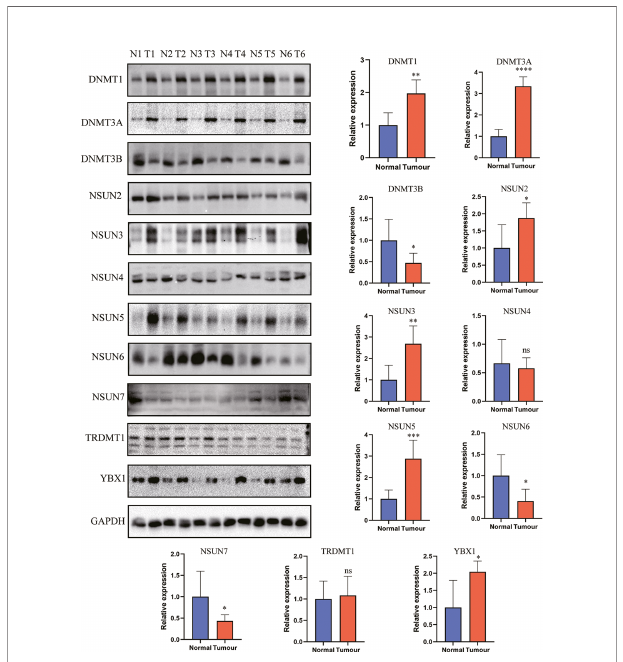
FIGURE 10 | The expression level of m 5 C regulators in PAAD and control tissues. * represents p value < 0.05, ** represents p value < 0.01, *** represents p value < 0.001, **** represents p value < 0.0001, ns means "not statistically signi fi